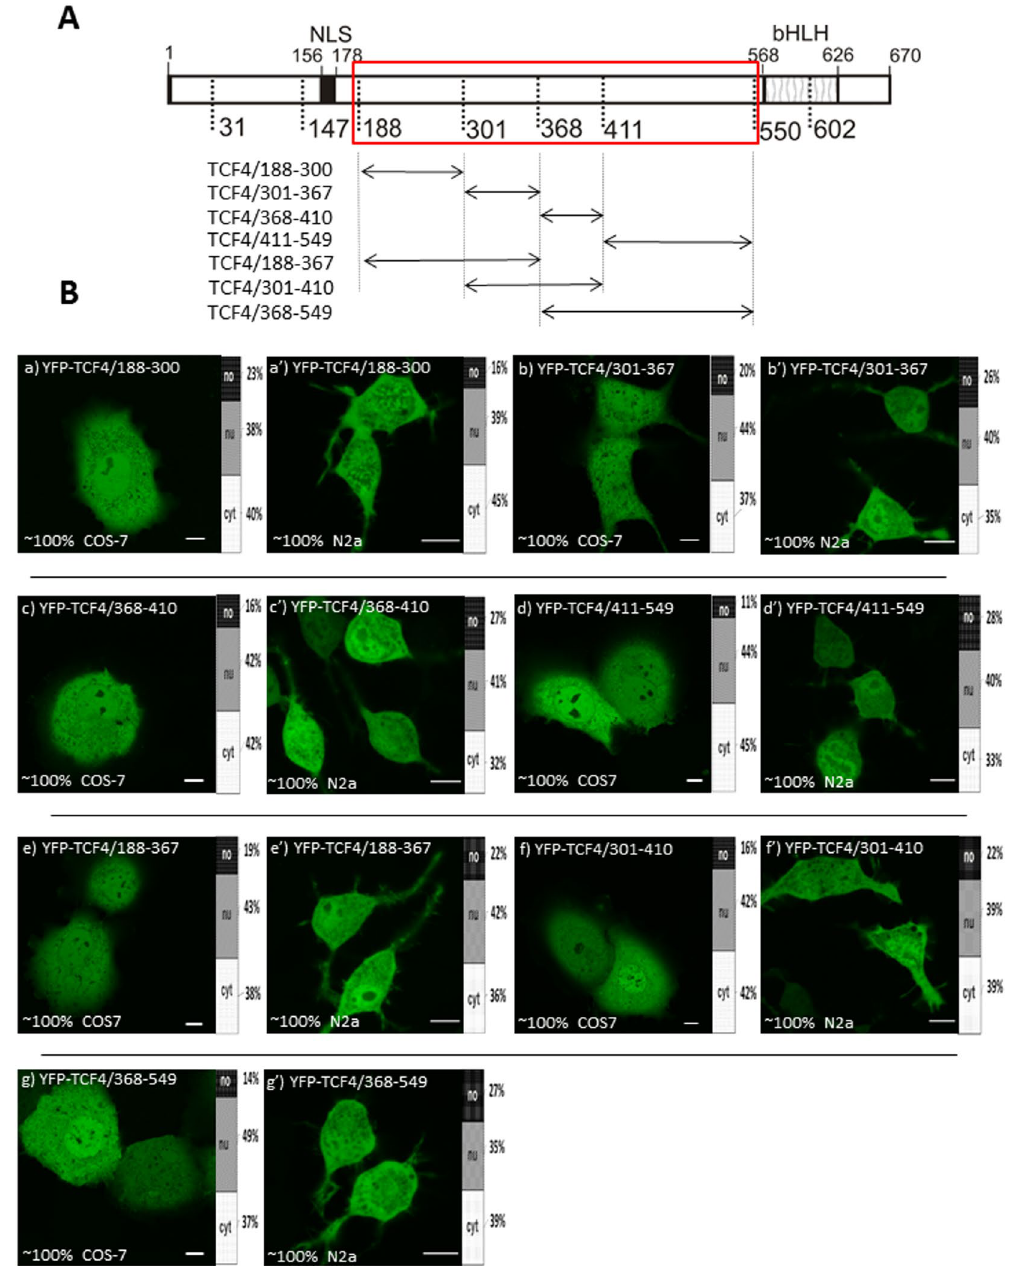
Figure 4. Subcellular distribution of deletion mutants (188-549aa) of TCF4 ( A ) Schematic representation of TCF4 protein. Region of the studied area of TCF4 is shown by the red rectangle. Expressed deletion mutants of TCF4 are depicted as arrows. The length of each domain in the diagram is arbitrary. ( B ) Subcellular distribution of deletion mutants of TCF4. Subcellular localizations of the expressed proteins were analysed by confocal microscopy 20-24 h after transfecting COS-7 and N2a cells. Representative images (single confocal plane for confocal microscopy) of subcellular distribution of the derivatives of TCF4/188-549 area. Bar, 10 µ m. Ratios between mean fluorescence intensity in cytoplasmic, nuclear and nucleolar compartments are presented as an accumulated bar graph (no- nucleolus; nu- nucleus, cyt- cytoplasm). (a,a’) YFP-TCF4/188-300, (b,b’)